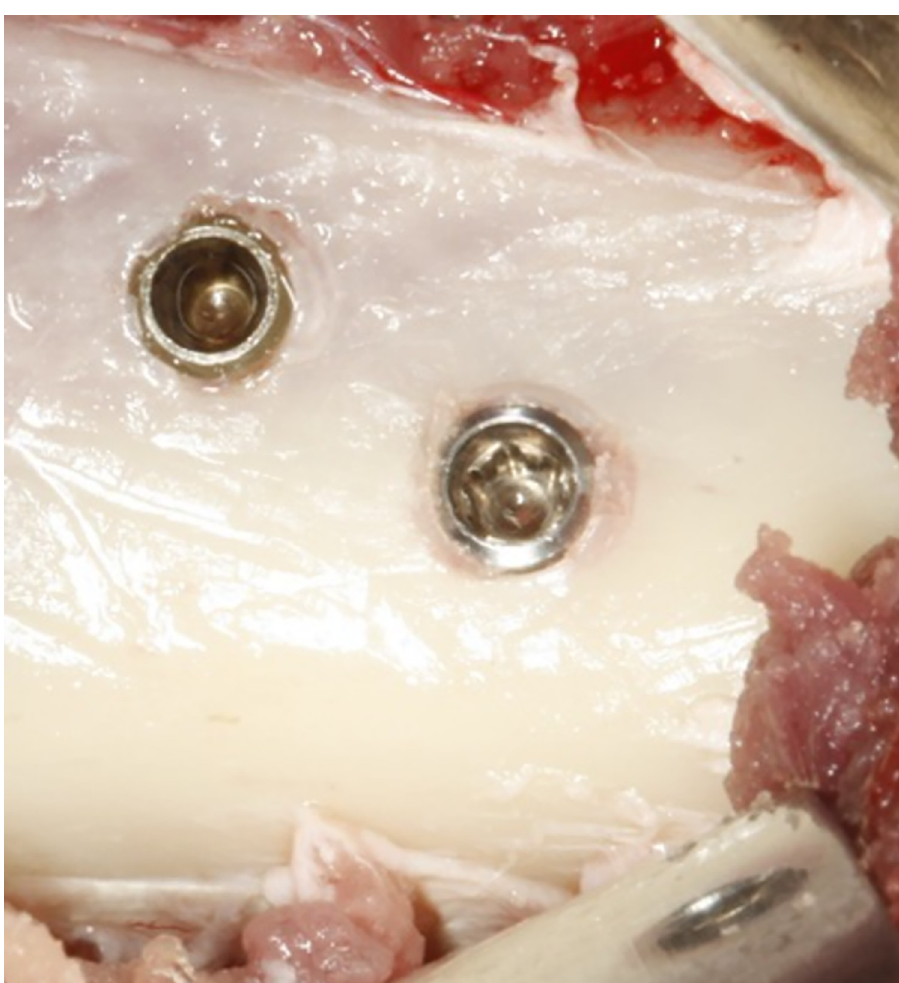
Fig 1. Surgical procedures to install the implants: (A) Installation of implants in the iliac crest while maintaining the safety distance between them (5 mm). (B) Removal the bone blocks with the implants after 2 and 4 weeks using a trephine drill with a 5mm internal diameter. (C) The iliac crest region after removal of the bone block with the implant. (D) Trephined bone block with the